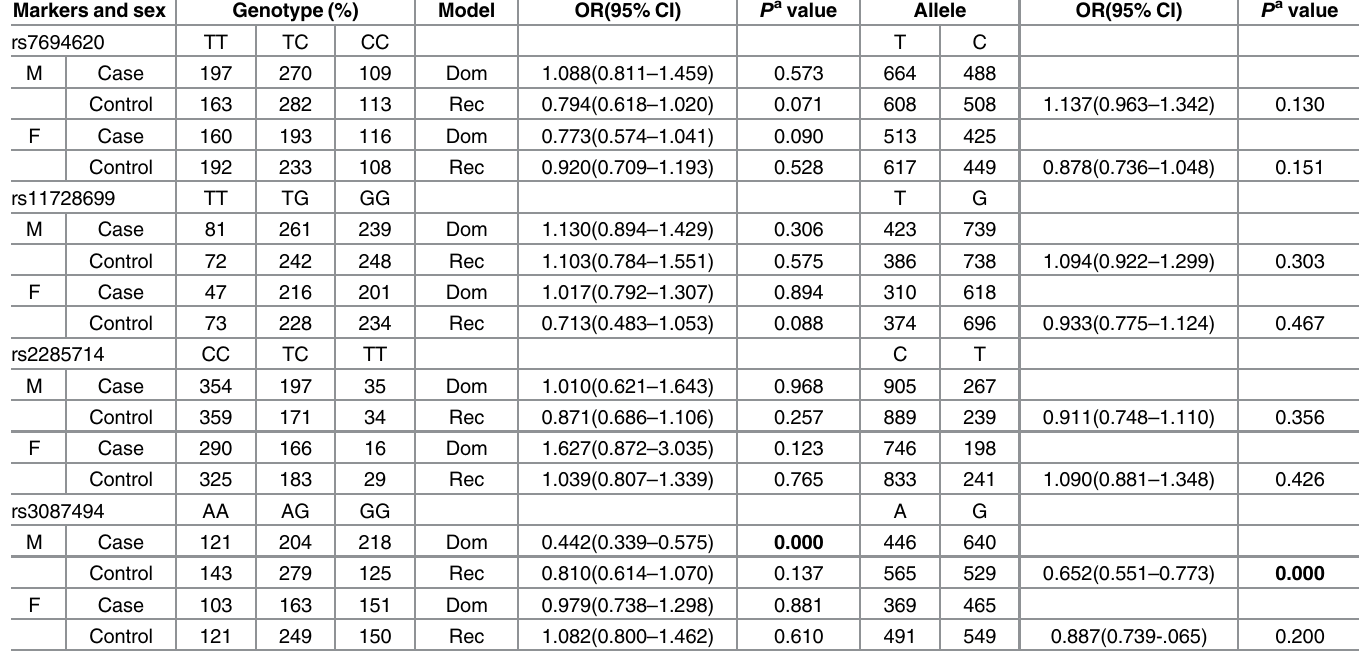
Table 5. Sex-specific genotype distribution and allele frequency differences between schizophrenia patients and healthy controls for four PLA2G12A SNPs.